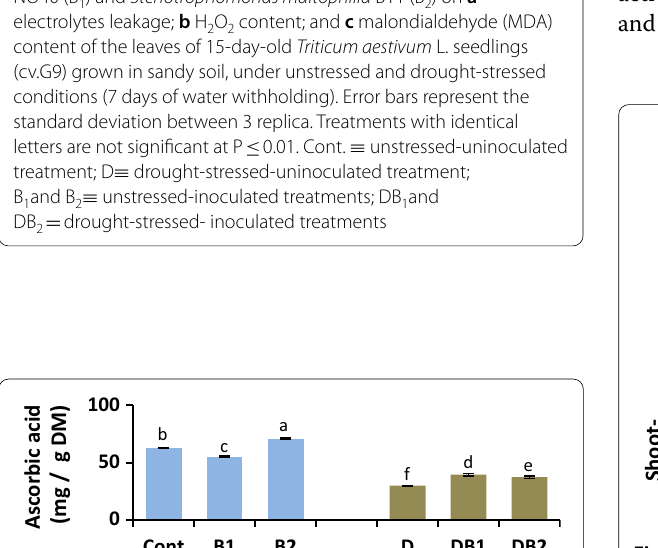
Fig. 6 Effect of bacterial inoculation with Azospirillum brasilense NO40 (B 1 ) and Stenotrophomonas maltophilia B11 (B 2 ) on ( a ): the contents of free proline in roots; ( b ): in shoots of the 15-day-old Triticum aestivum L. seedlings (cv. G9) grown in sandy soil under unstressed and drought-stressed conditions (7 days of water withholding). Error bars represent the standard deviation between 3 replica. Treatments with identical letters are not significant at P 0.01. Cont. unstressed-uninoculated ≤ ≡ treatment; D drought-stressed-uninoculated treatment; ≡ B 1 and B 2 unstressed-inoculated treatments; DB 1 ≡